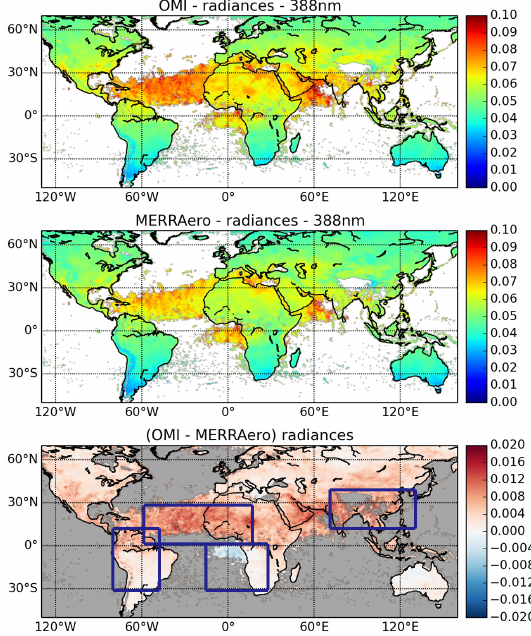
Figure 1. TOA monthly mean radiances at 388nm observed by OMI (top) and calculated with VLIDORT using MERRAero aerosol fields (middle) for July 2007. Difference of radiances OMI minus MERRAero (bottom). Dark blue boxes delimit the African dust region (60 ◦ W–20 ◦ E, 0–30 ◦ N), the southern African (10 ◦ W– 30 ◦ E, 0–30 ◦ S) and South American (80 ◦ W–50 ◦ W, 30 ◦ S–10 ◦ N) biomass burning regions and the Asian region (70 ◦ E–130 ◦ E, 10– 40 ◦ N). The color grey means no data under the OMI criteria “qual- ity flag =